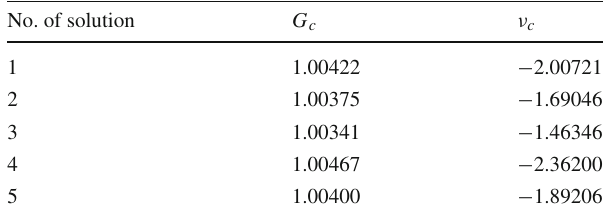
Table 1 Initial conditions for five interior solutions for G (cid:5) ( r = 0 ) = −